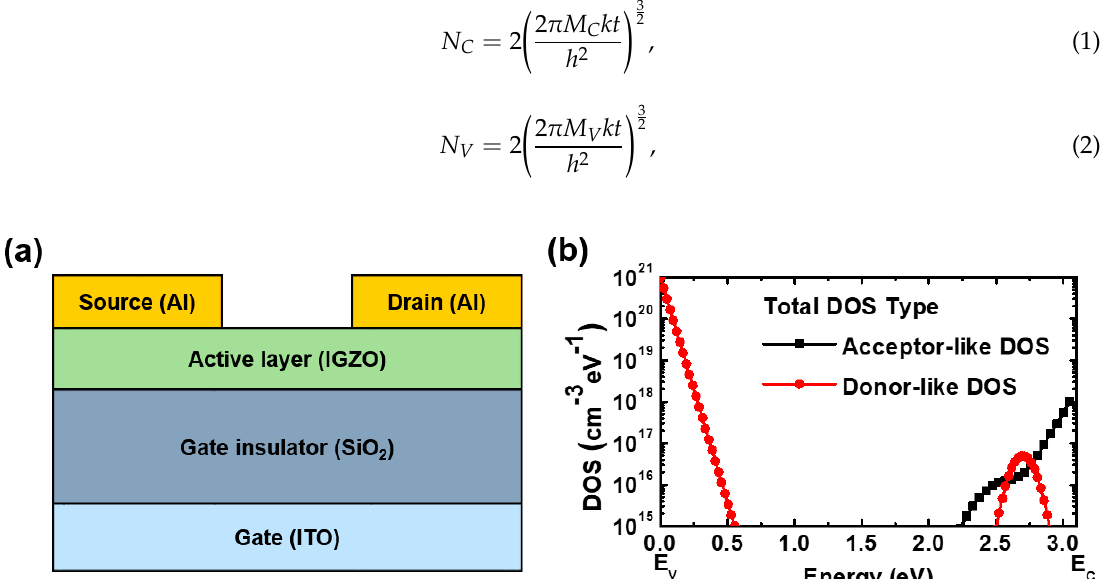
Figure 1. ( a ) Schematic cross-sectional view of the structure of the bottom-gate staggered structure of the device used in this work. ( b ) Density of states (DOS) is shown as a function of energy (E). The black squares are total acceptor-like traps sub-gap DOS, and the red circles are total donor-like traps sub-gap DOS.